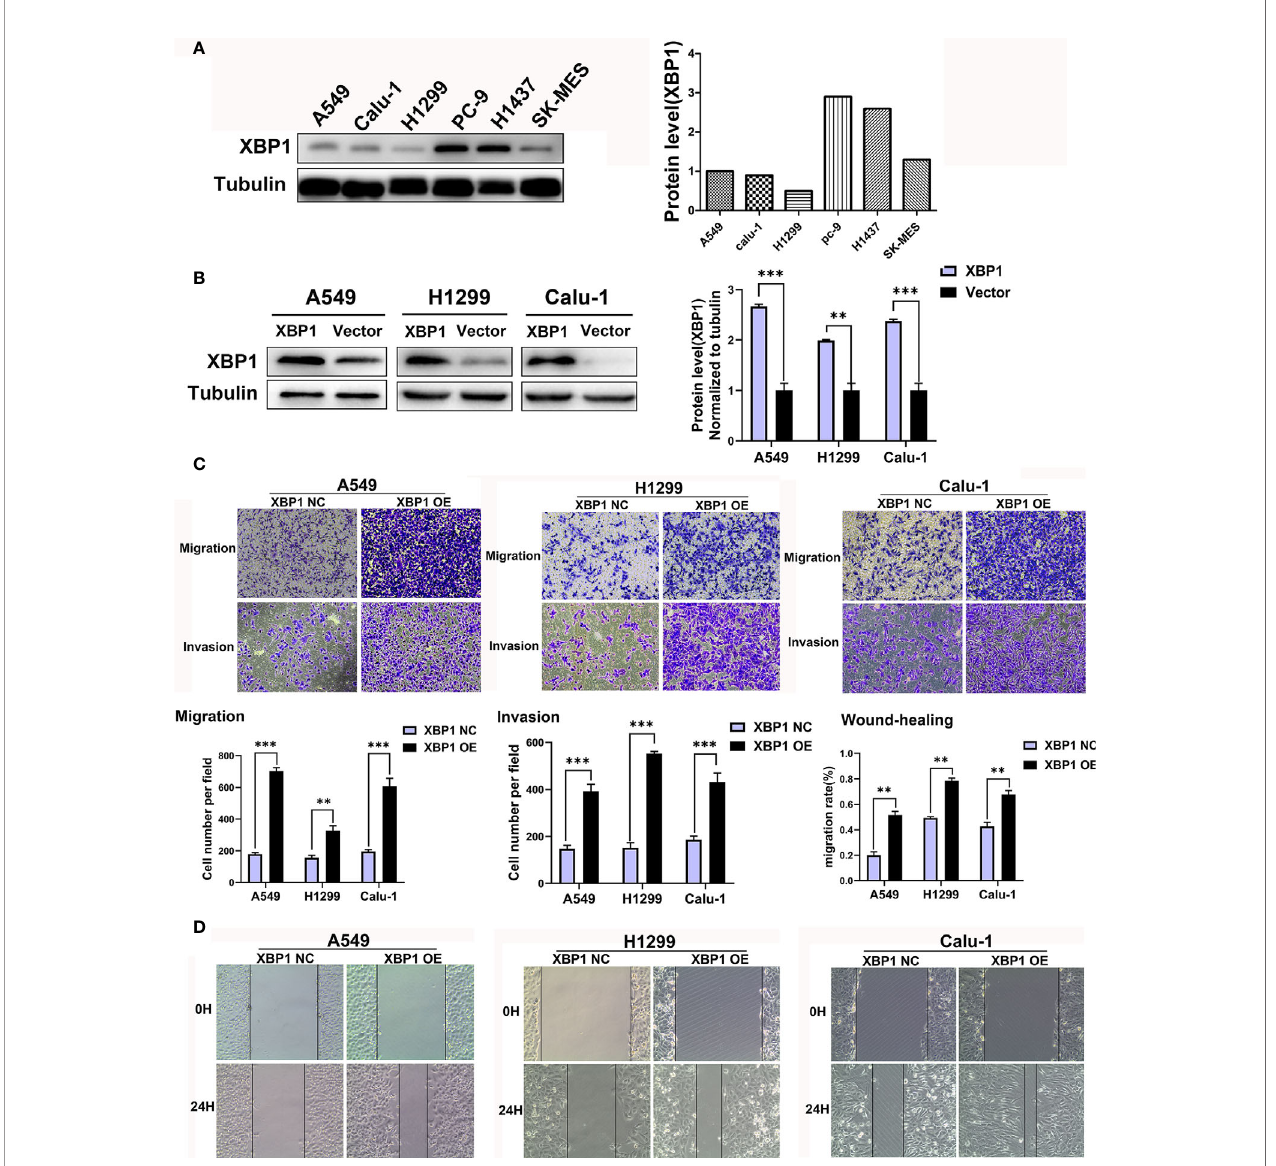
FIGURE 2 | XBP1 overexpression promotes lung cancer cells ’ migration and invasion. (A) Western blot analysis of XBP1 expression in NSCLC cell lines. The highest expression of XBP1 protein occurs in PC-9 cells. (B) Western blot showed the expression of XBP1 in A549, H1299 and Calu-1 cells after transfected with XBP1-overexpression or negative control. (C) Transwell migration and invasion assays of A549, H1299 and Calu-1 cells transfected with XBP1 overexpression and negative control. (D) Wound-healing assay of A549, H1299 and Calu-1 cells transfected with XBP1 overexpression and negative control. Data were represented as the mean ± SEM of three independent experiments. ** P < 0.01, *** P <